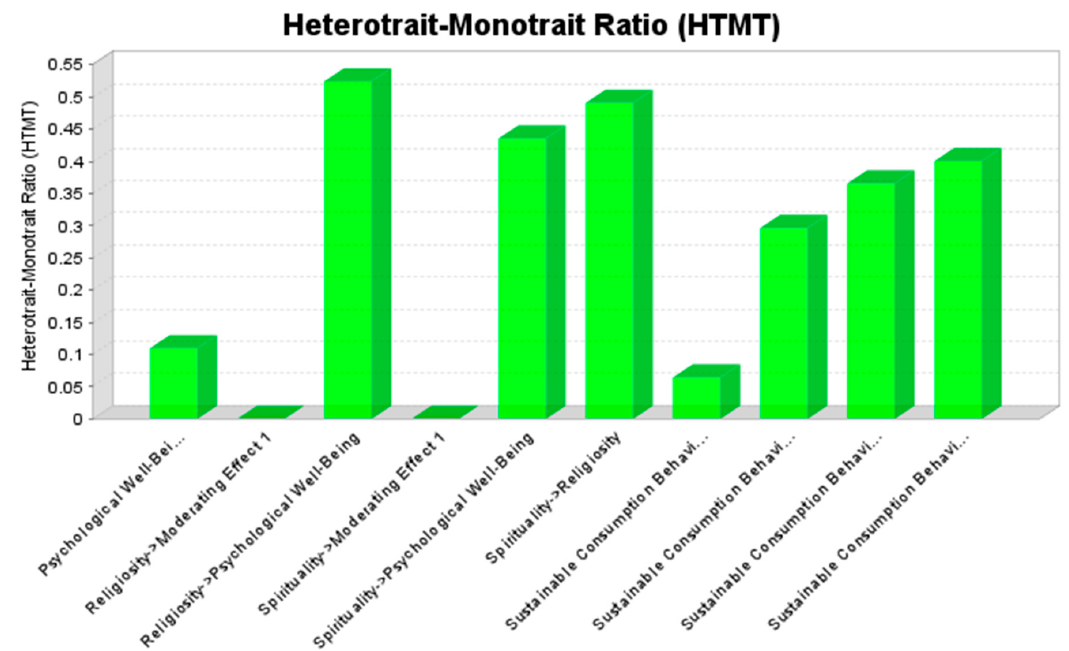
Figure 2. Heterotrait–Monotrait (HTMT).